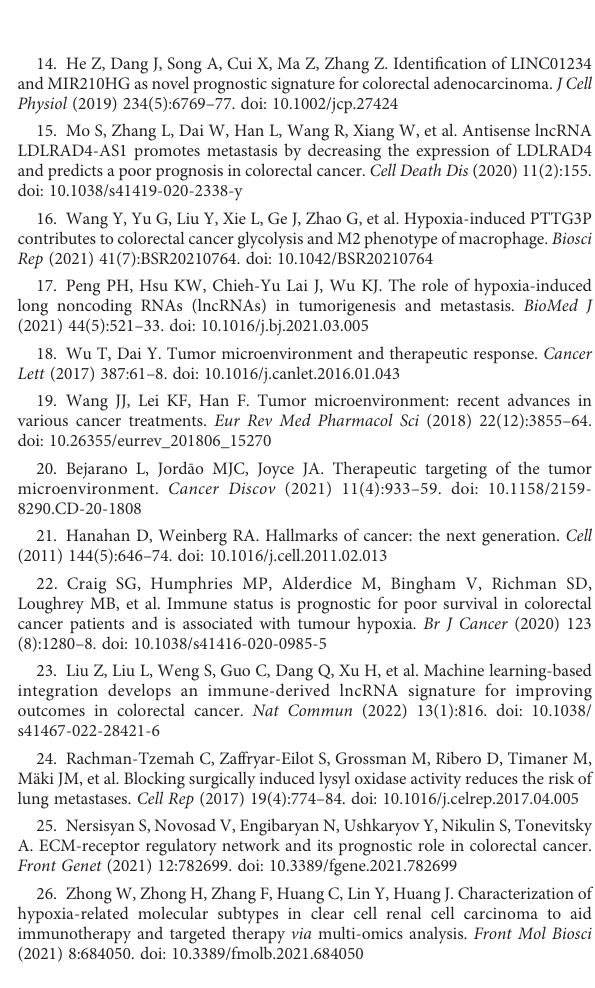
SUPPLEMENTARY FIGURE 1 Identi fi cation of biological function and hypoxia-related lncRNAs in TCGA. KEGG (A) and GO (B) analysis between hypoxia-high and hypoxia-low groups were performed by Gene set enrichment analysis (GSEA). Different expression of hypoxia-related lncRNAs was identi fi ed by volcano plot (C) and heatmap (D) . SUPPLEMENTARY FIGURE 2 Identi fi cation of biological function and immune-related lncRNAs in TCGA. KEGG (A) and GO (B) analyses between high-immune score and